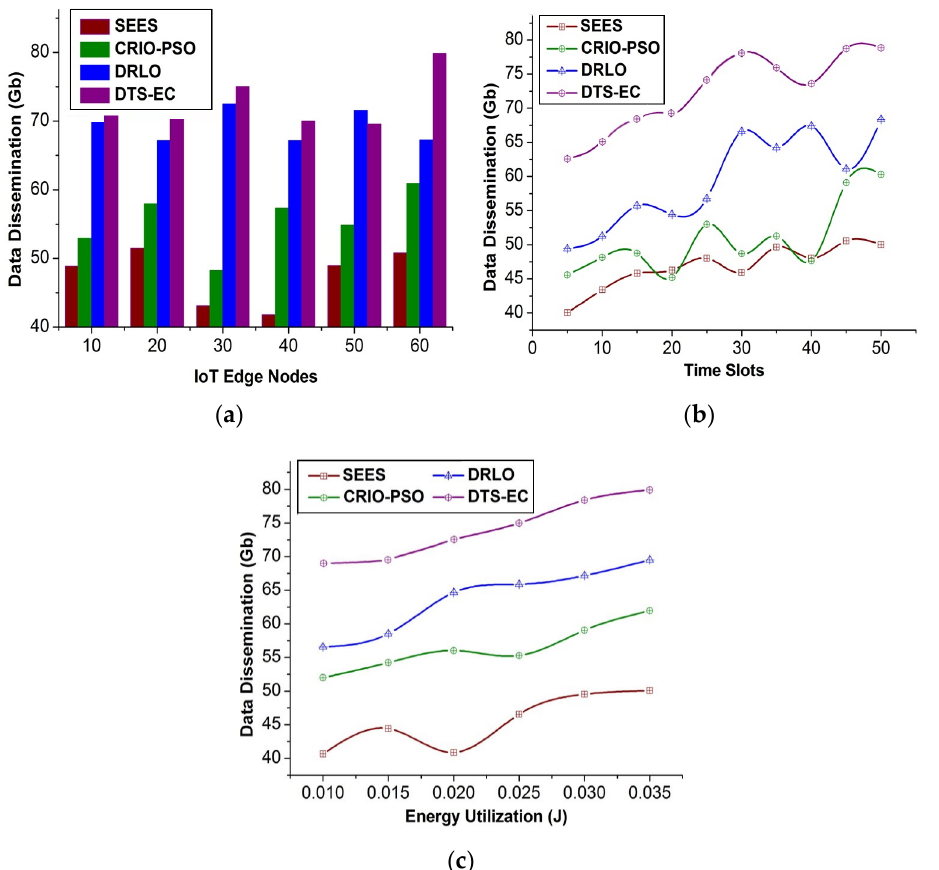
Figure 6. Data dissemination comparisons for ( a ) IoT edge nodes, ( b ) time slots, ( c ) energy